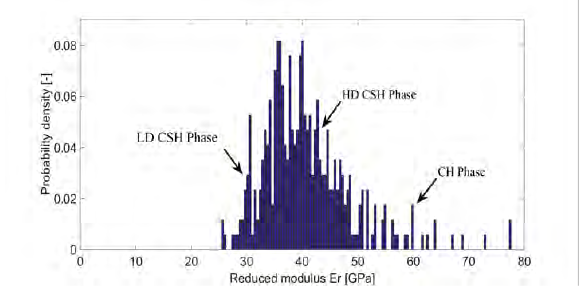
Figure 6. ModCem 0.00 – Reduced modulus his-